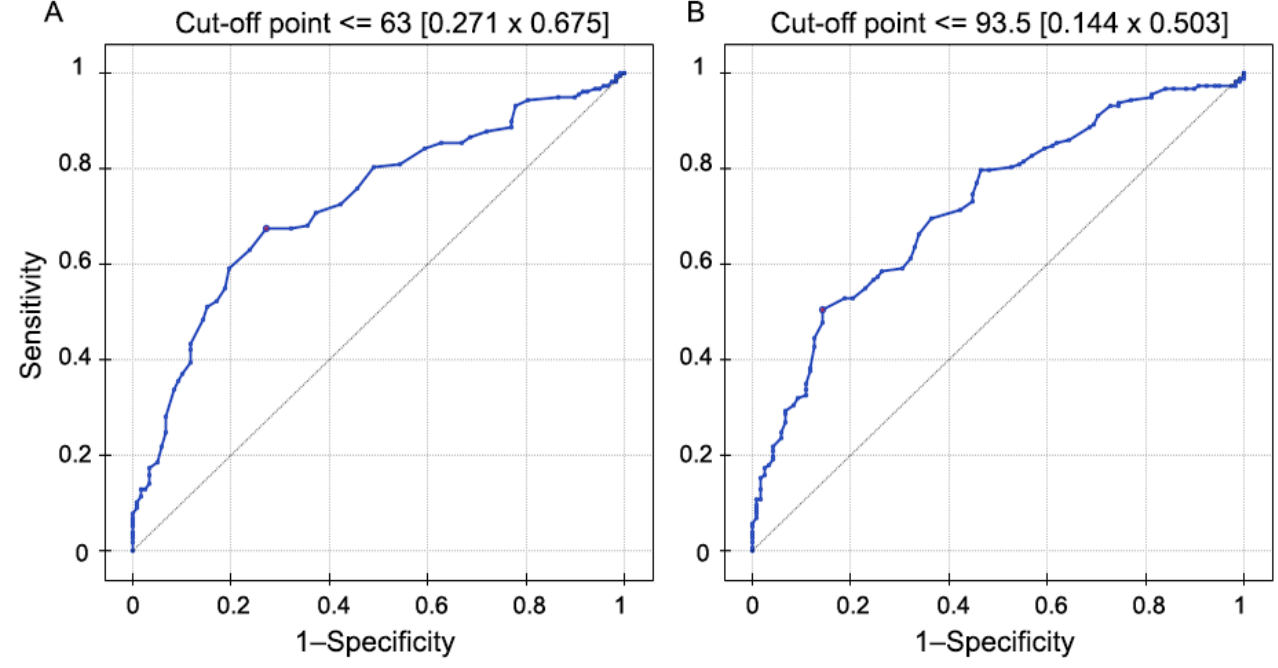
Figure 2. Optimal cut-off values for GCIPL ( A ) and pRNFL ( B ) thicknesses in the investigated cohort estimated by ROC analysis. ROC, receiver operating characteristic; GCIPL, ganglion cell–inner plexiform layer; pRNFL, peripapillary retinal nerve fiber layer.